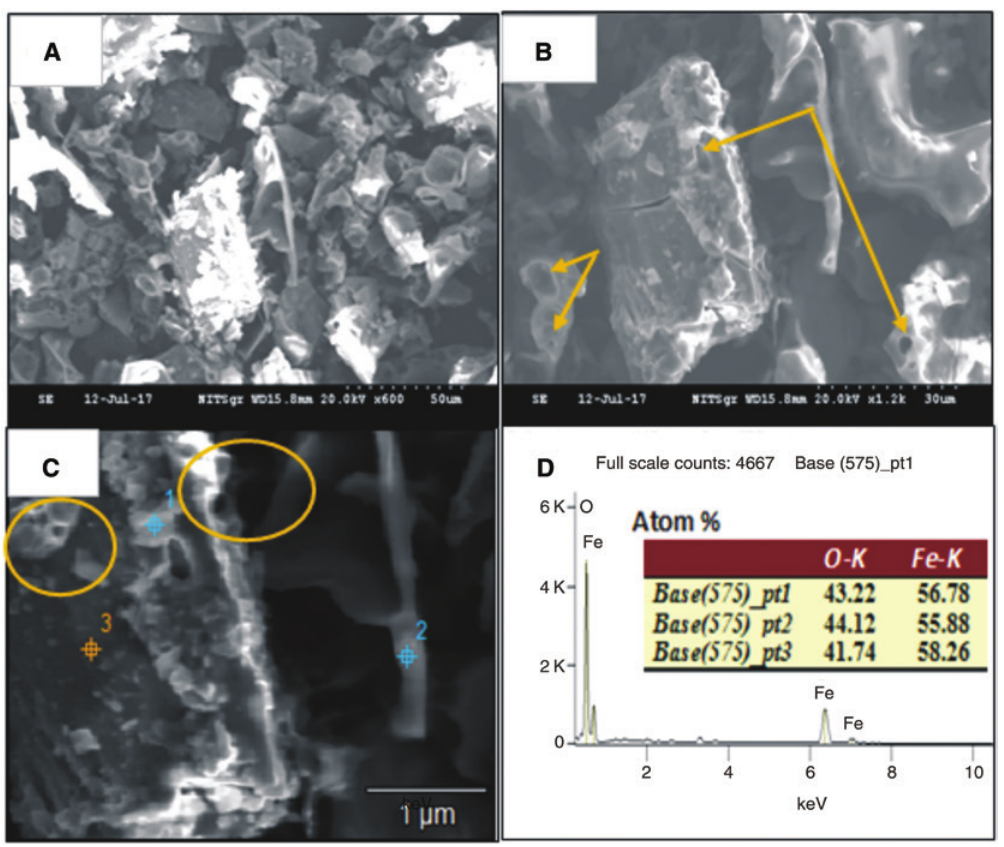
Figure 3: Scanning electron microscopy images of iron oxide nanoparticles (A–C). Energy dispersive X-ray analysis of iron oxide nanoparticles